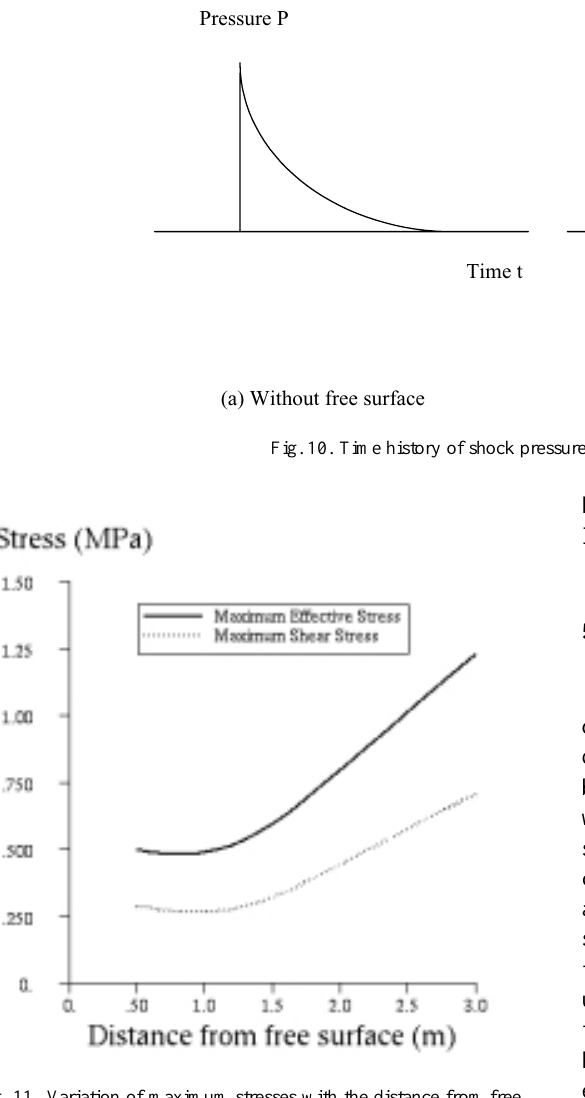
Fig. 11. Variation of maximum stresses with the distance from free surface to the layered